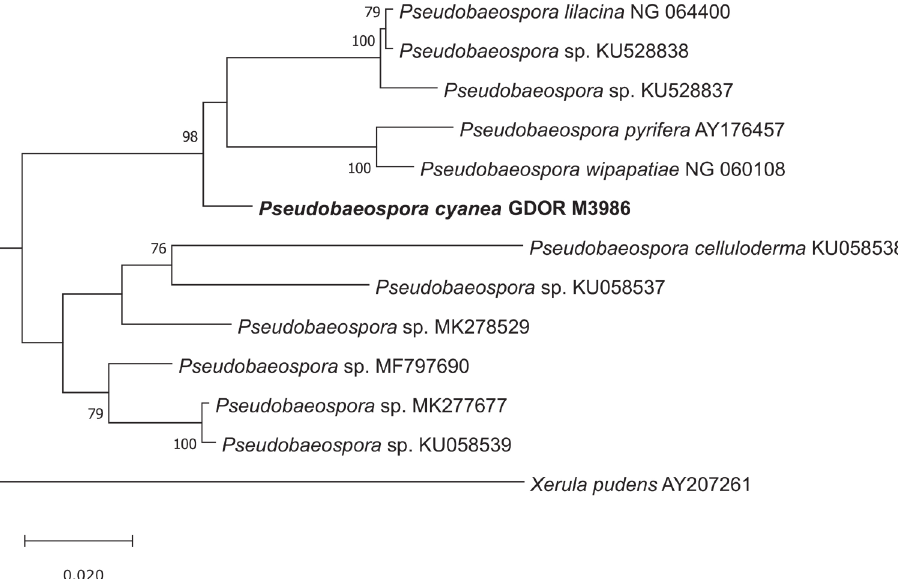
Figure 4. Maximum-likelihood phylogenetic tree with 500 bootstrap replicates, obtained from the LSU sequence alignment of Pseudobaeospora sequences in GenBank. Xerula pudens was used as outgroup